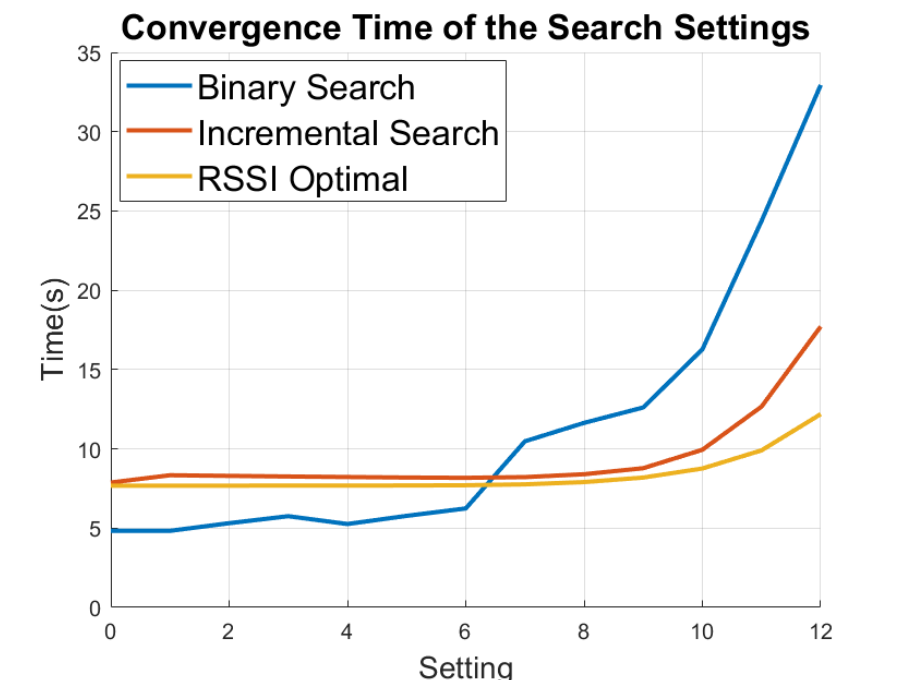
Figure 4. The convergence times of the different ADR search